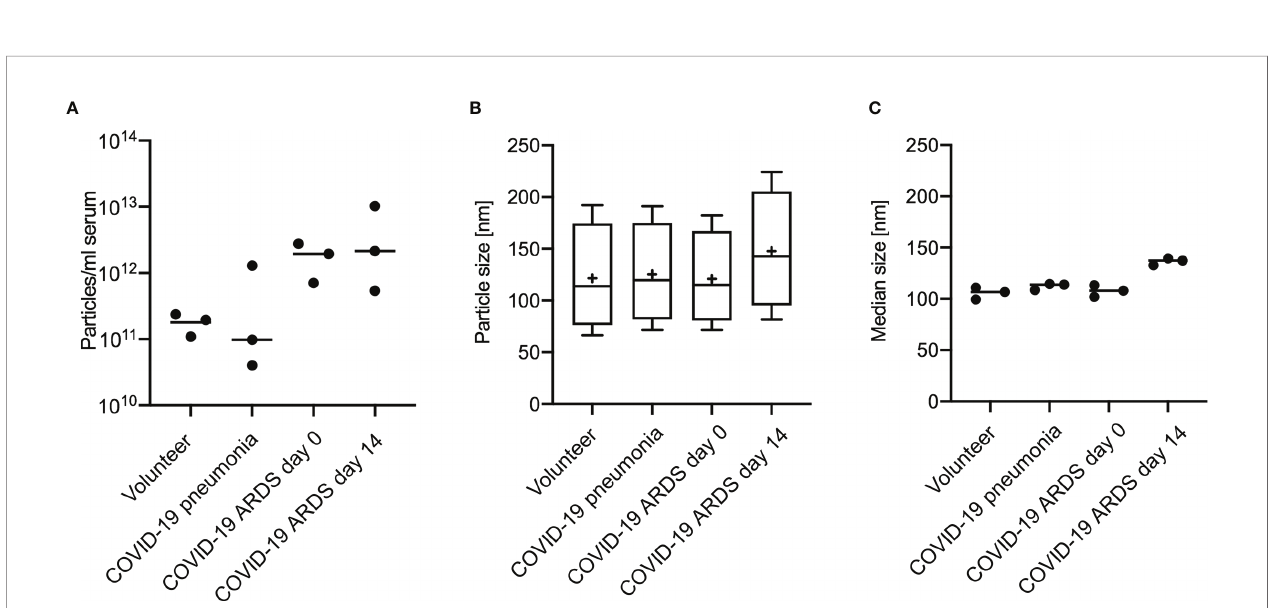
FIGURE 2 | Morphology of serum EVs by transmission electron microscopy. Images are representative for at least two biological replicates for controls (A) , COVID- 19 pneumonia (B) , COVID-19 ARDS at admission to the ICU (C) and at day 14 of ICU treatment (D) . Scale bars shown at the right lower corner of the images are 100 nm.